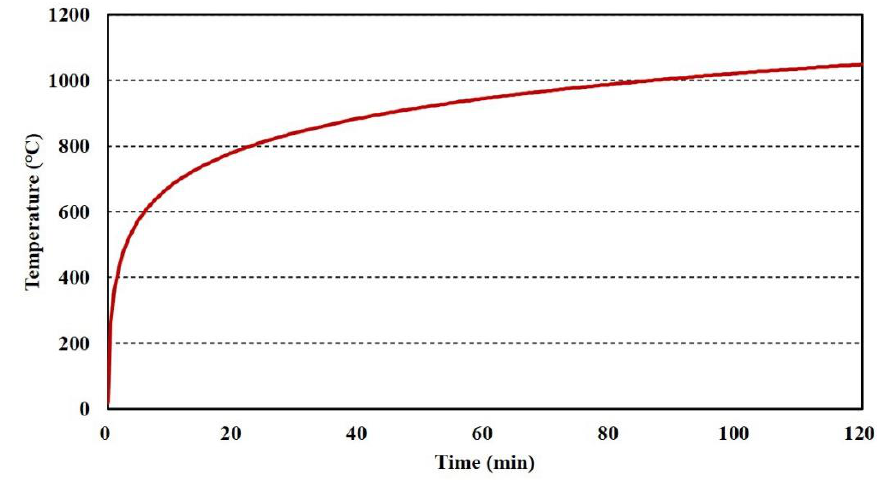
Figure 5. Standard fire curve for fire tests based on Korean Standards [12,13,17,18].